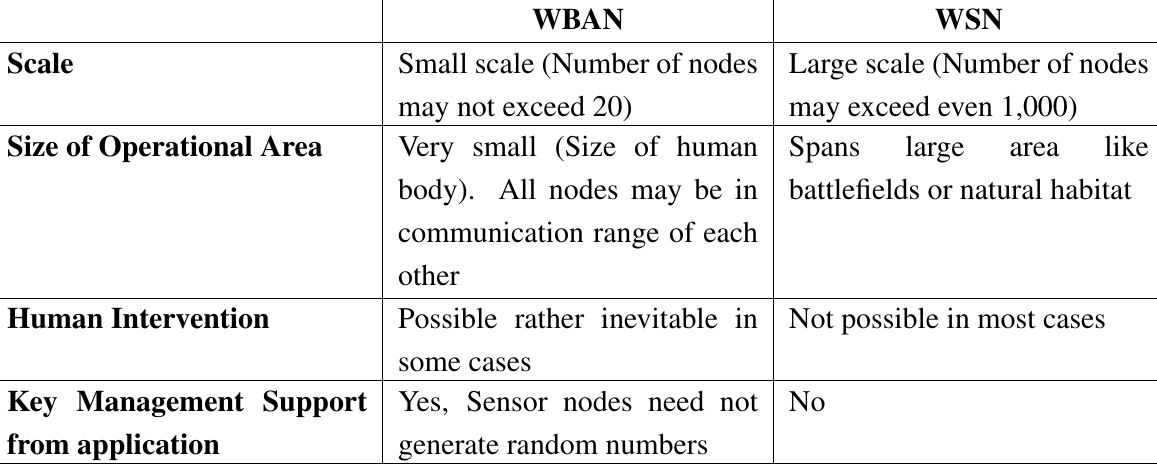
Table 1. Differences between WBAN and WSN.